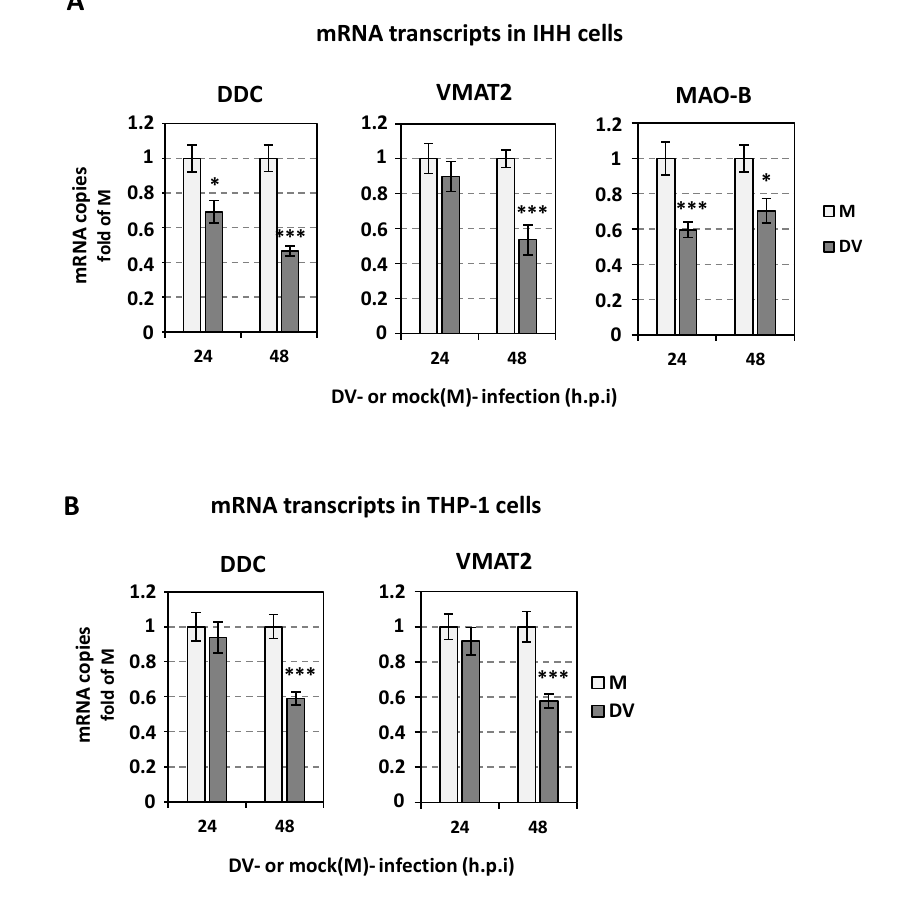
Figure 14. DV infection downregulates the expression of the catecholamine biosynthesis/metabolism related genes in immortalized human hepatic (IHH) and blood monocytic (THP-1) cell line. IHH ( A ) and THP-1 ( B ) cells, were inoculated with DV (MOI = 1), or mock-infected (mock, M) and further cultured for the indicated h.p.i. DDC, VMAT2, and MAO-B mRNA levels were determined by RT- qPCR analysis and normalized to YWHAZ mRNA. Values are expressed relative to the ones derived from mock-infected (mock, M) cells, at each time point. The mean values ± standard deviations from three independent experiments in triplicate are featured. * p < 0.05, *** p < 0.001 vs. M at each